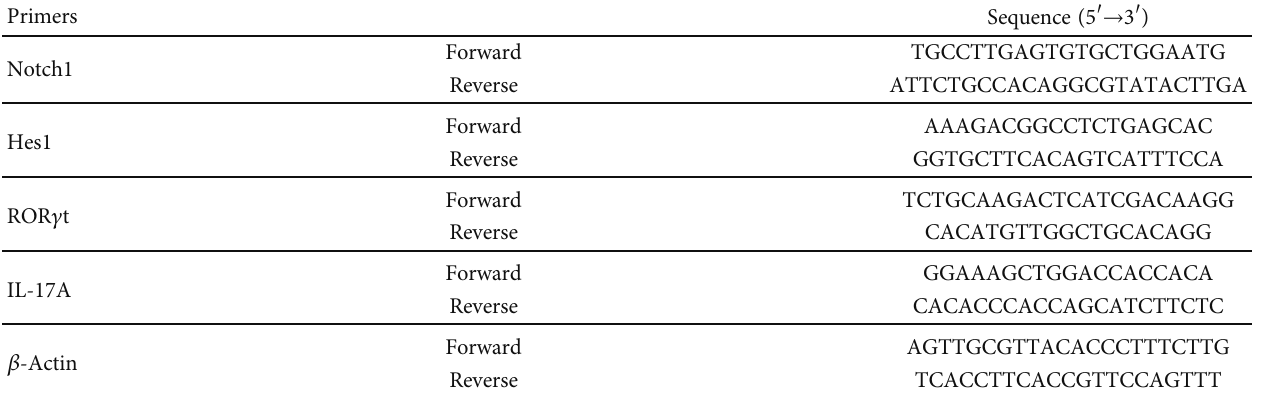
Table 1: List of primers for